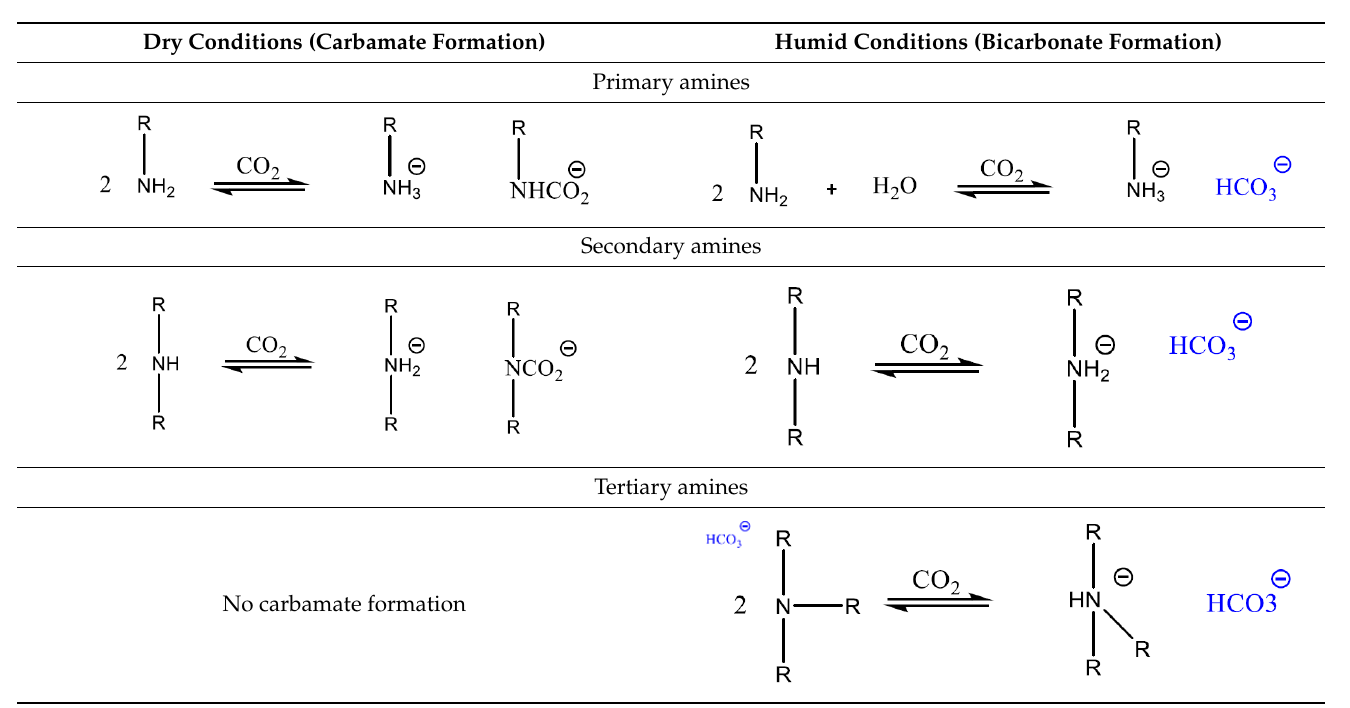
Table 12. Reactions of CO 2 with primary, secondary, and tertiary amines under (a) dry and (b) moist conditions (Reprinted with permission from ref. [26]).